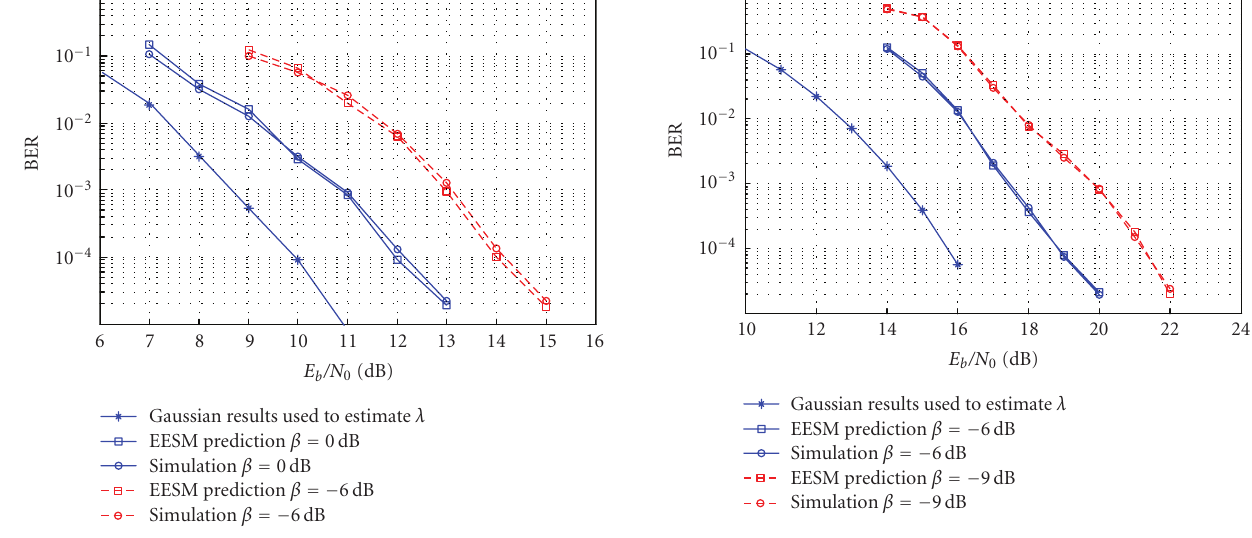
Figure 11: Validation of EESM technique, Alamouti scheme, η = 6b/s/Hz, λ = 22 . 6, TU-6 channel.